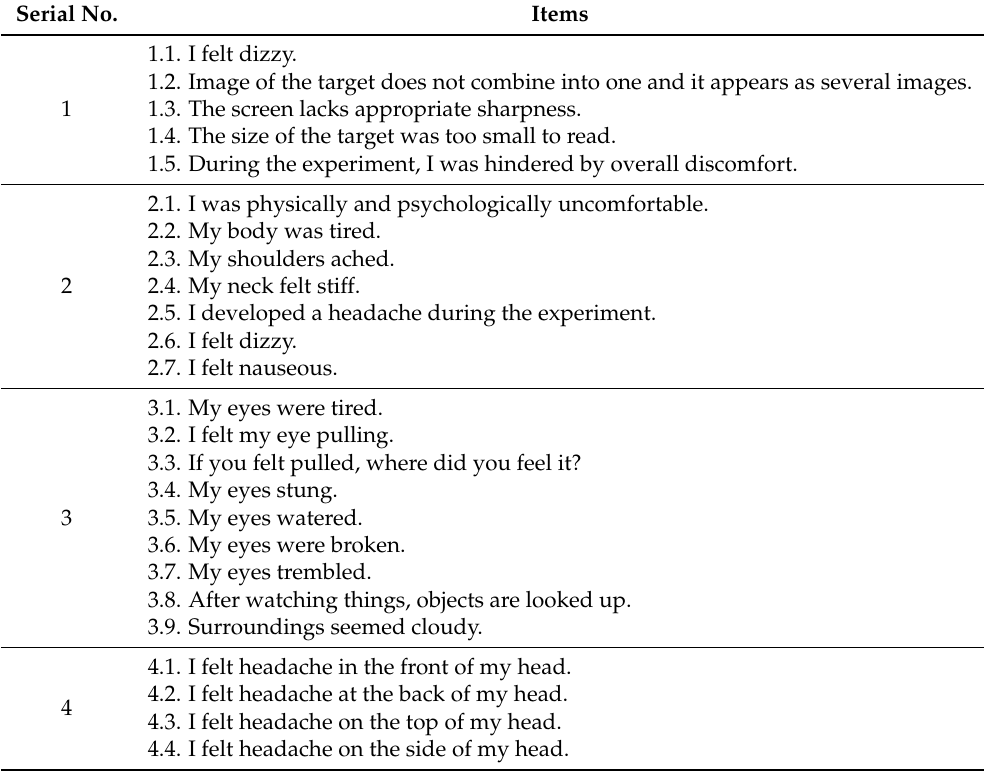
Table 2. Questionnaire of subjective symptoms.